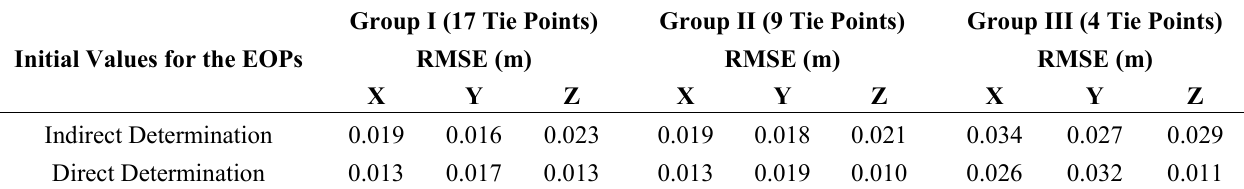
Table 3. Root mean square errors (RMSEs) obtained with three different distributions of tie points using the original fisheye images.